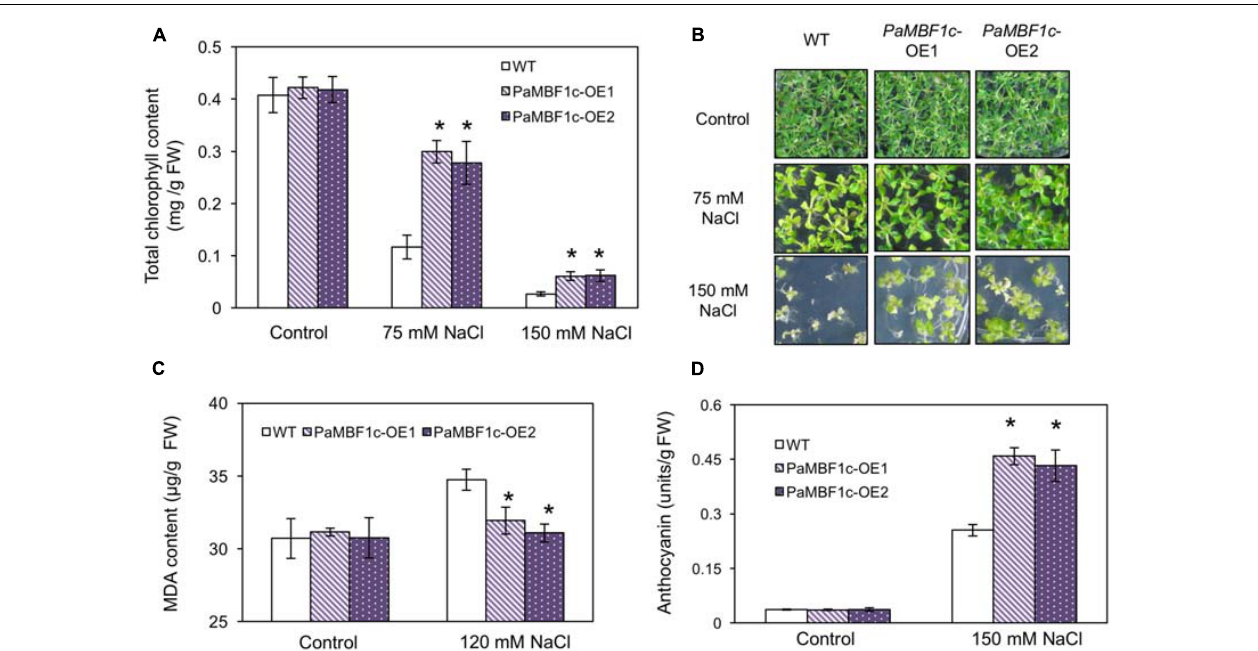
FIGURE 5 | Chlorophyll, malondialdehyde (MDA), and anthocyanin levels in PaMBF1c -OE lines. (A,B) PaMBF1c -OE lines retained more chlorophyll content than WT at 75 and 150 mM NaCl. (C) PaMBF1c -OE lines showed lower MDA level than WT. MDA levels were examined with 21-day-old seedlings grown on MS plates with 0 or 120 mM NaCl. (D) PaMBF1c -OE lines accumulated higher amount of anthocyanin than WT. Anthocyanin content was measured with 10-day-old seedlings grown on MS plates with 0 or 150 mM NaCl. Error bars represents standard deviation of mean values of at least three independent experiments ( n = 25 seedlings per each treatment). Asterisks indicate statistical significance in LSD test ( p <